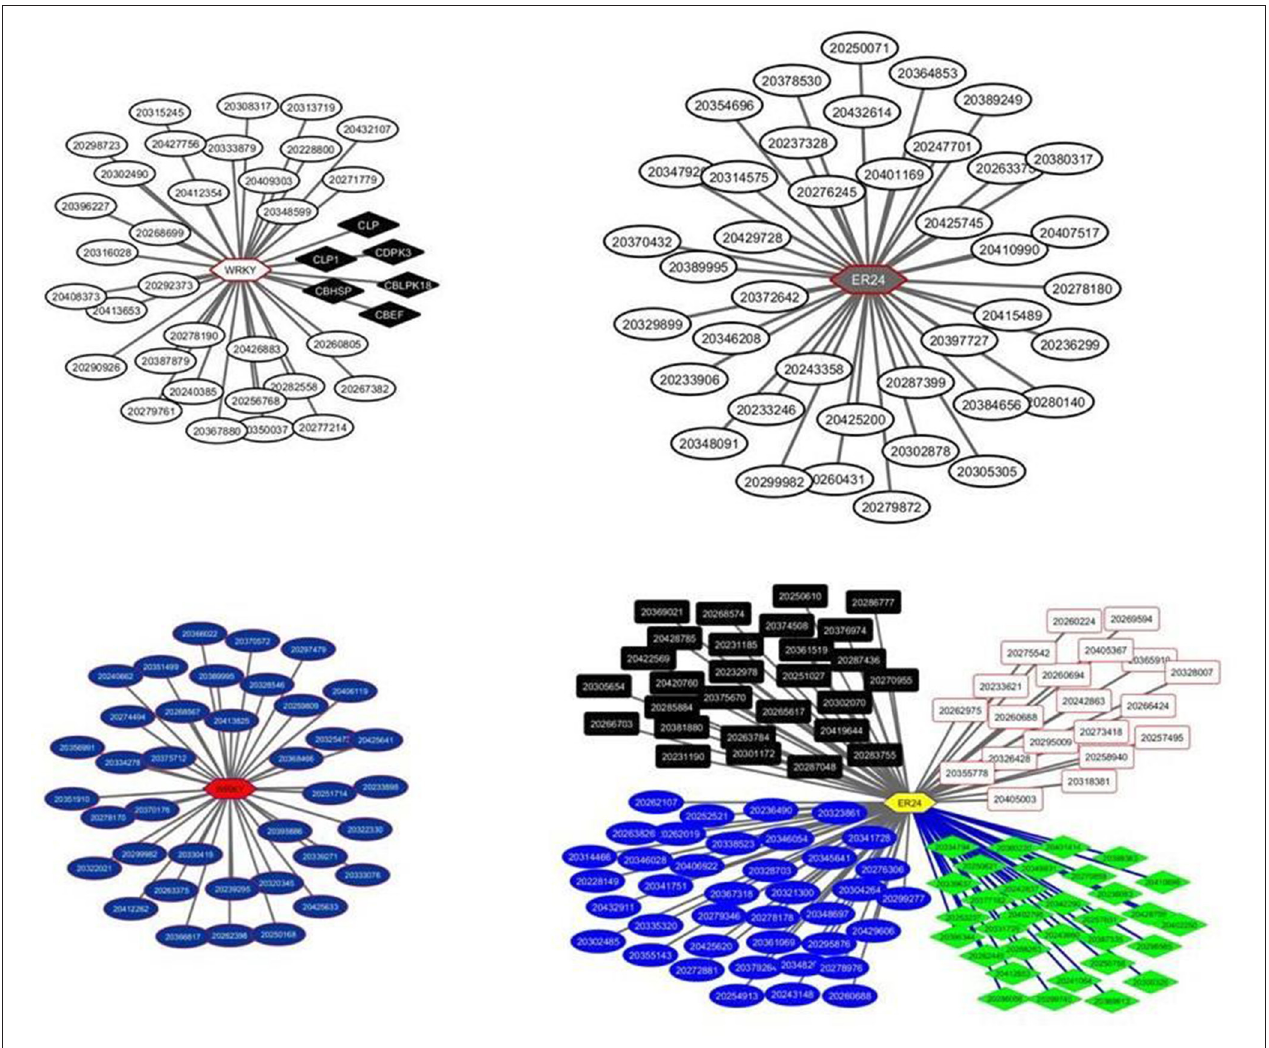
FIGURE 2 | Transcriptional regulatory networks in tomato fruit ripening using in house microarray data. The left panel represents the WRKY22 network with the modules, M40 and M59, each comprising of 38 transcripts, respectively. The top right panel represents the ER24 network with one module, the M6 comprising 40 transcripts. The low right panel represents again the ER24 regulating 4 distinct modules, the M31, M63, M104, and M162, comprising 39, 28, 32, and 26 transcripts, respectively. Modules are color-coded. Hexagons represent transcripts encoding transcription factors whereas rectangles, square and ellipses represent transcripts regulated by